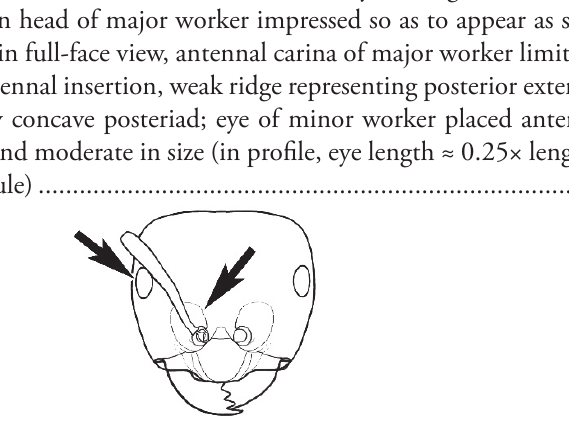
36 Appressed setae in all workers fine and forming pubescence that largely obscures underlying cuticle, which is matt in appearance (northern Australia) ( JDM 485 ) (Fig. 44a–g) ..................................................................... postlei